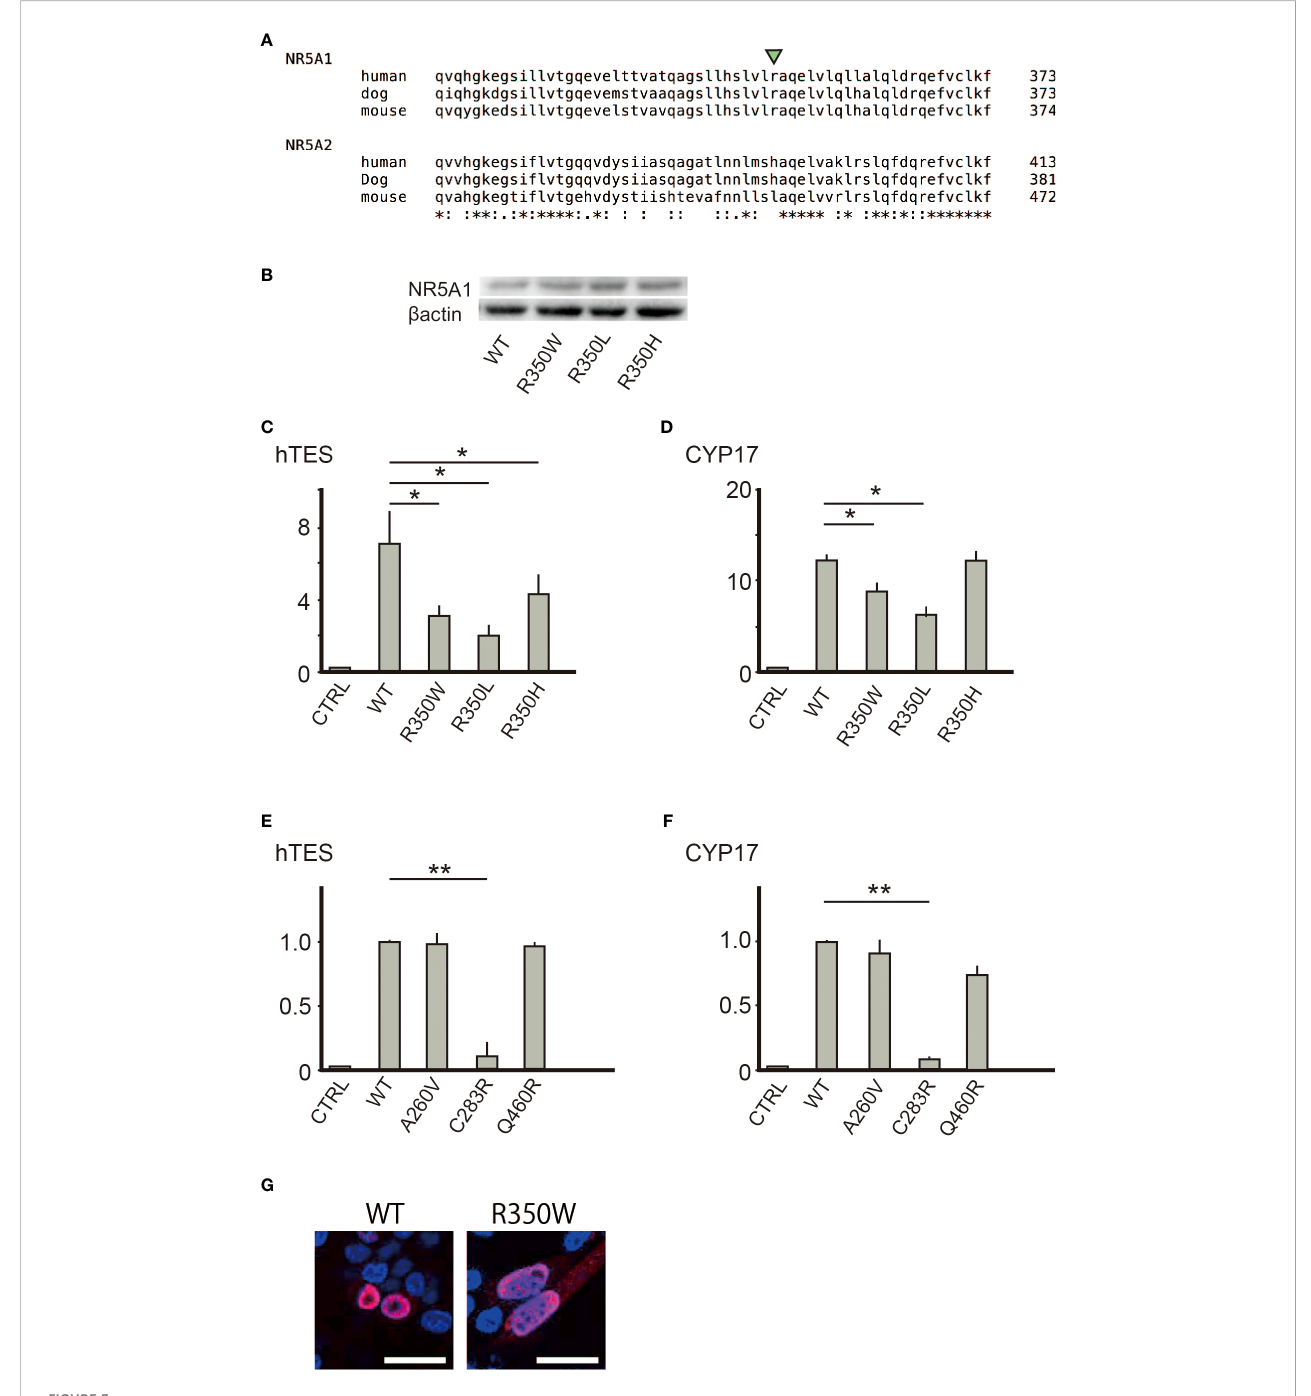
FIGURE 3 (A) R350 is conserved among NR5A1 of various species, but not in NR5A2. (B) Substitution of the 350 th arginine with tryptophan, leucine, or histidine did not affect the protein expression levels. (C, D) Substitution of the 350 th arginine with leucine or histidine reduced the trans-activating ability in hTES and the CYP17 promoter. Asterisks indicate statistical signi fi cance (*, P <0.05). (E, F) Of the three missense variants (p.A260V, p. C283R, and p.Q460R) suggested to cause 46,XY DSD, only p.C283R reduced the trans-activating ability in hTES and the CYP17 promoter. Data sets represent activation of the reporters relative to wild-type whose value was adjusted to 1.0. The mean and SD values of three to fi ve biological replicates measured were calculated. Asterisks indicate statistical signi fi cance (**, P <0.001). Unpaired Student ’ s t-test was used to demonstrate statistically signi fi cant difference between the given sample and the control. (G) Immuno fl uorescence of transiently transfected CHO cells with the wild type or R350W NR5A1 expression vectors. The nuclear localization was identical between wild type and R350W (red) White bar indicate